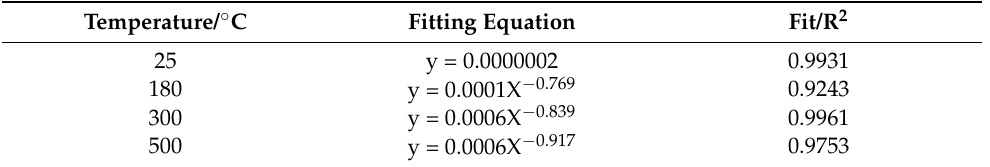
Table 3. Fitting equations of the oxidation rate curves of the Al-Sn alloy.